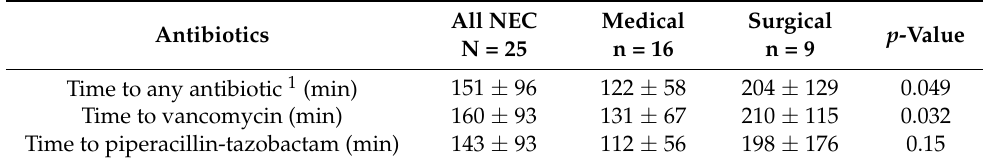
Table 4. Timing of antibiotic treatment by disease severity. Antibiotics